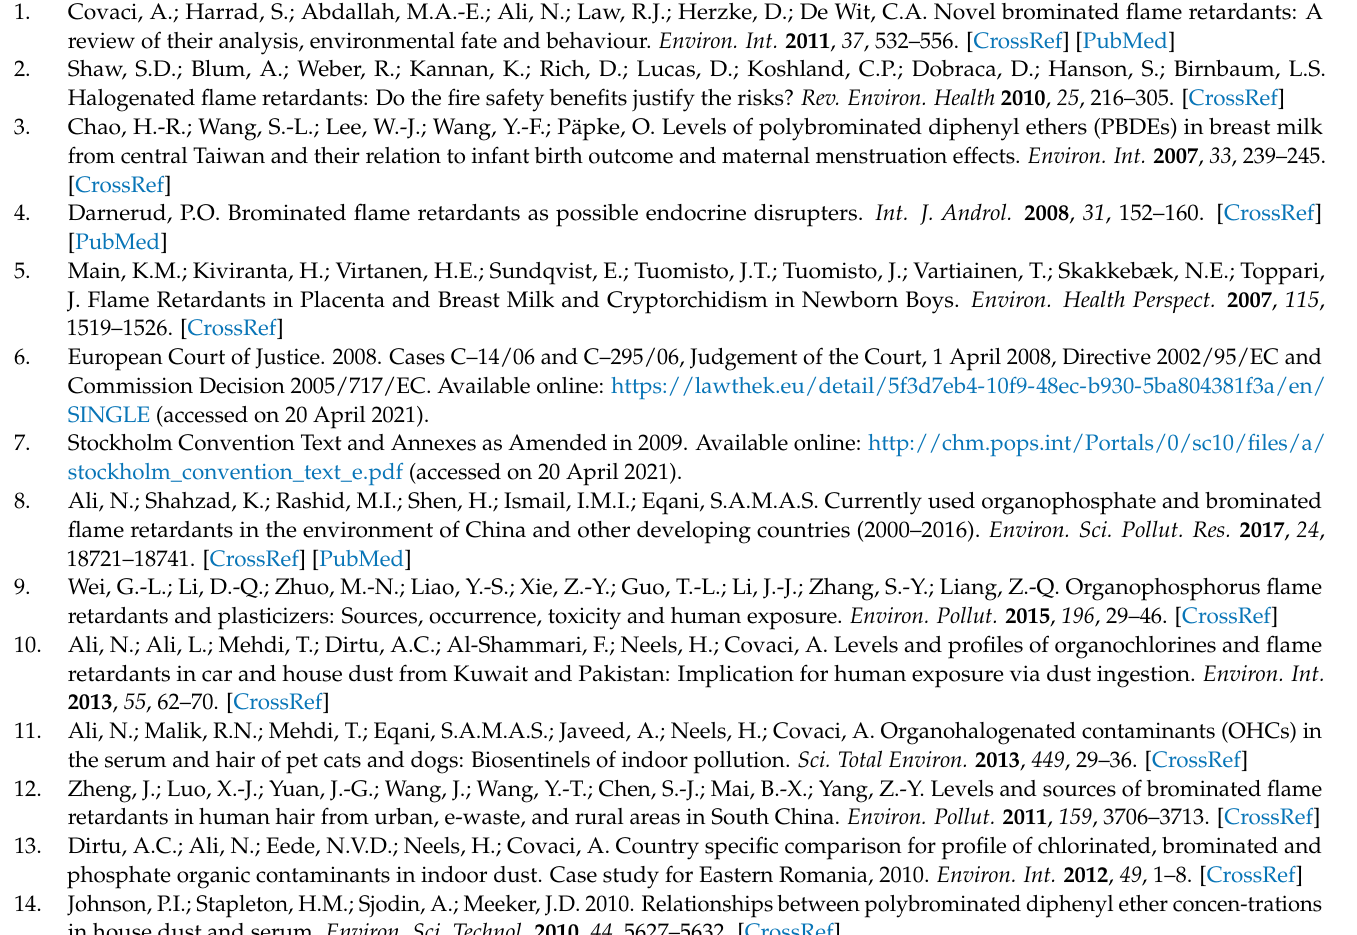
collection, Table S2: Comparing median levels of BFRs data from different countries for indoor dust (ng/g) and indoor air (pg/m 3 ), Table S3: Different exposure scenarios of estimated daily exposure via indoor dust ingestion (ng/kg/bw/day) and PM 10 (pg/kg/bw/day) to BFRs for Saudi young children from their